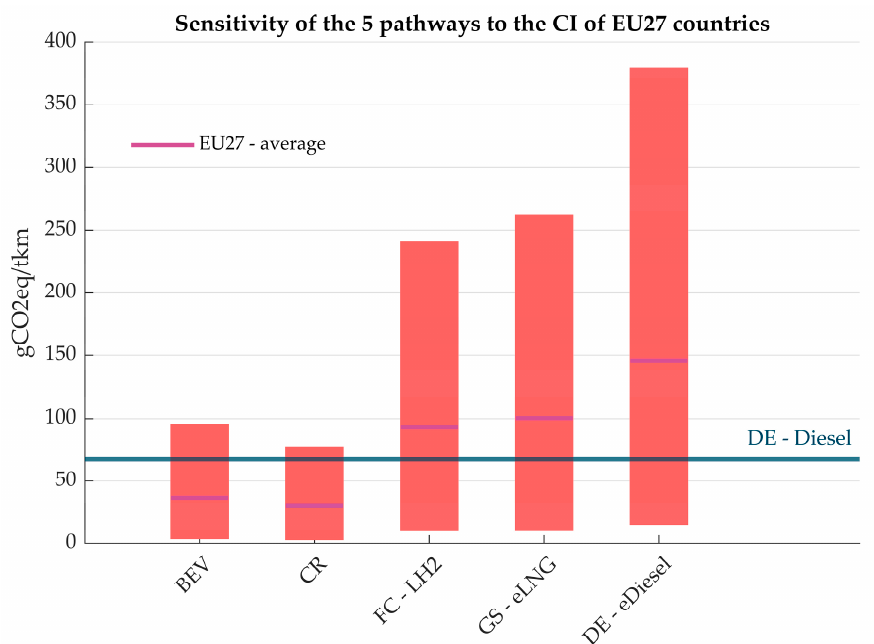
Figure 3. WTW results as function of the electricity Carbon Intensity.